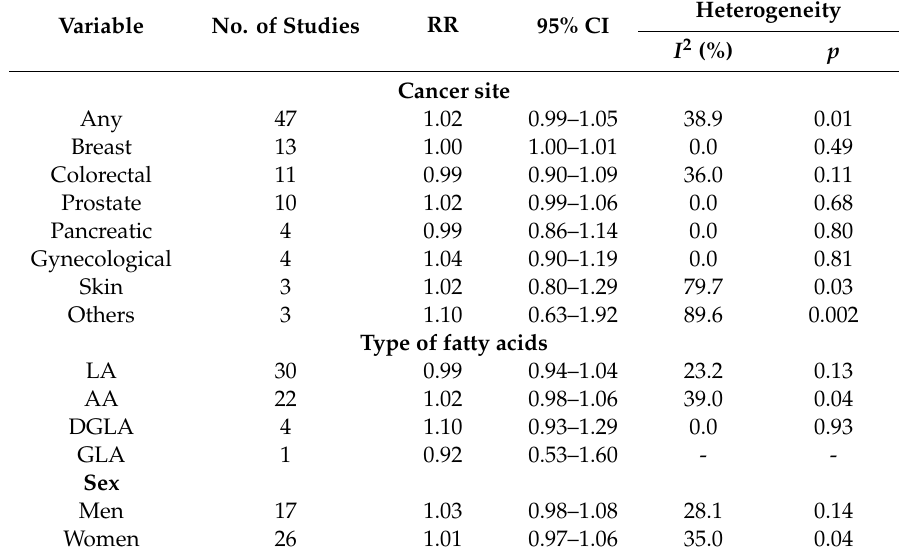
Table 1. Summary of pooled relative risks (RR) of cancer risk for n-6 polyunsaturated fatty acid (PUFA)